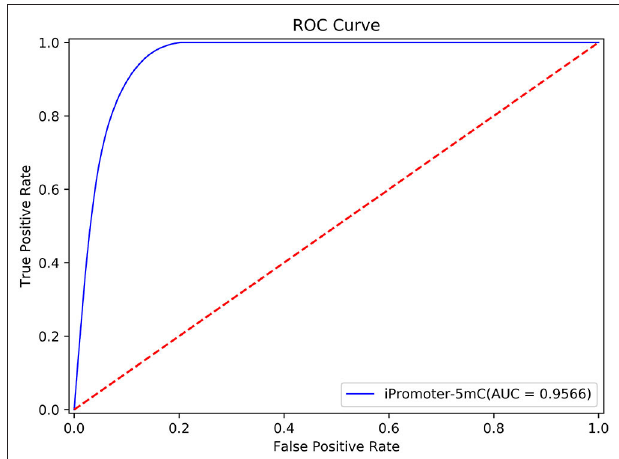
FIGURE 4 | The ROC curve of the S1 dataset on our model.